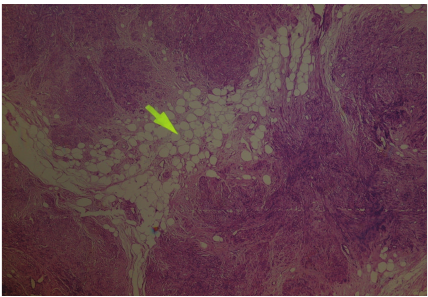
Figure 4: The figure shows spindle-shaped smooth muscle cell proliferation admixed with mature adipocytes (arrow)